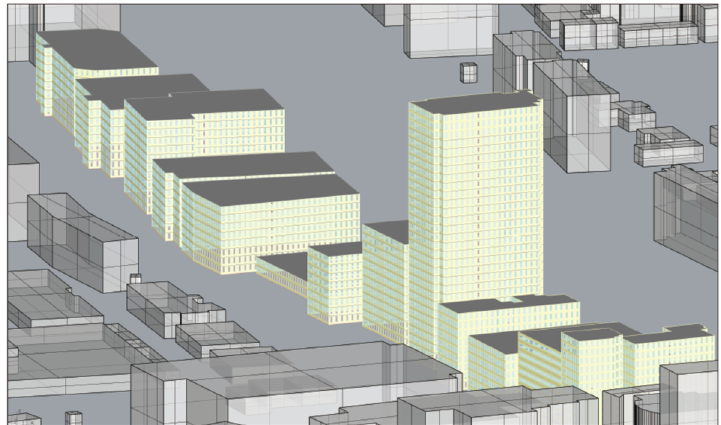
Figure 5. Existing buildings (yellow) with windows for the analyses.